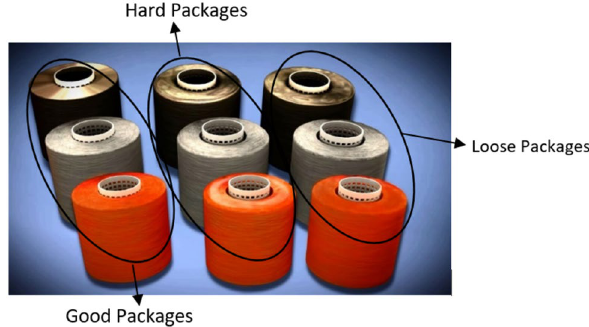
Figure 5. Different densities of soft winding packages [Courtesy of EL Sharq El Awsat